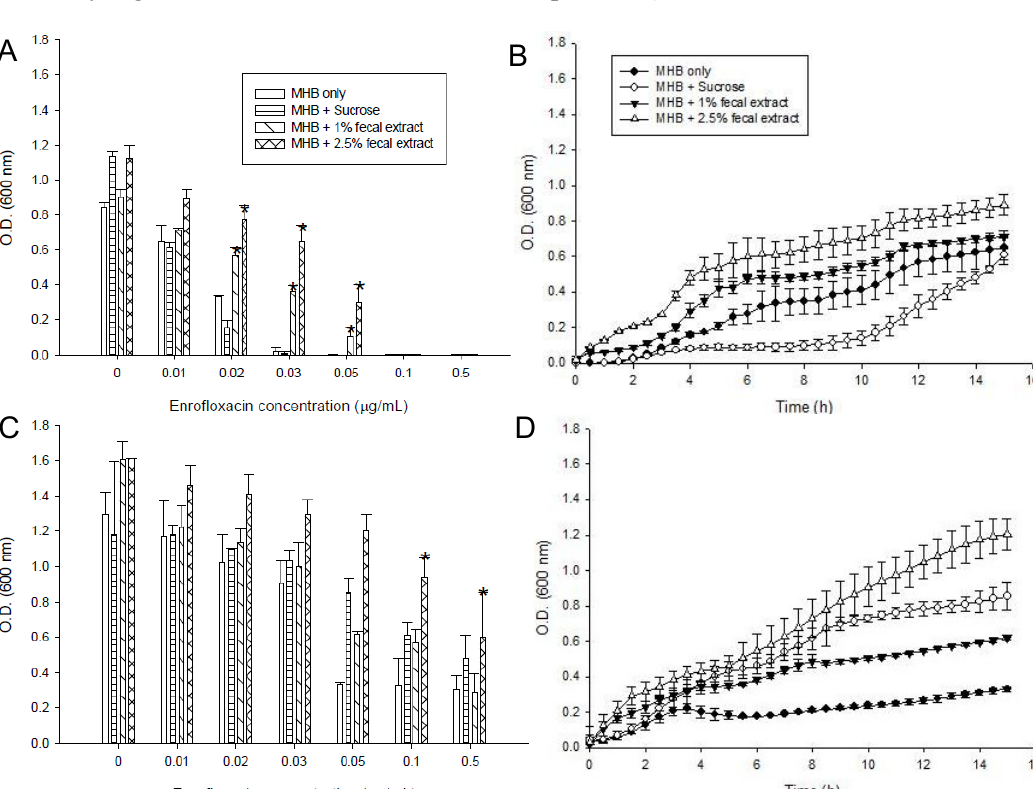
Figure 1. Effects of different concentrations of enrofloxacin on growth of S. enterica ATCC 13076 in media containing 5 mM sucrose, or 1 or 2.5% sterilized extract from a human fecal sample, ( A ) in the first passage; ( B ) Kinetics of survival with a sub-MIC concentration of enrofloxacin (0.01  g/mL); ( C ) Maximum cell growth measured in the third passage in media with different supplements; ( D ) Kinetics of growth of S. enterica in 0.05  g/mL of enrofloxacin measured in the third passage. Symbols represent averages of triplicates from three samples and error bars represent the standard deviations. * Indicates statistically significant differences from control ( p <